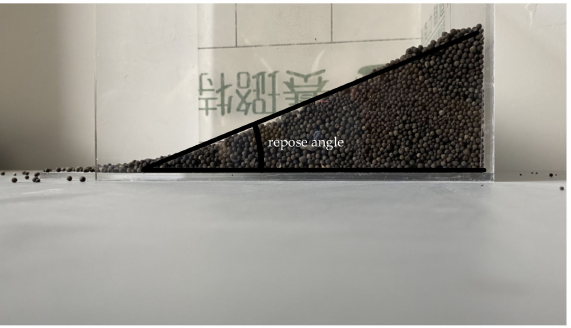
Figure 6. Test for determination of repose angle of granular fungal fertilizers.